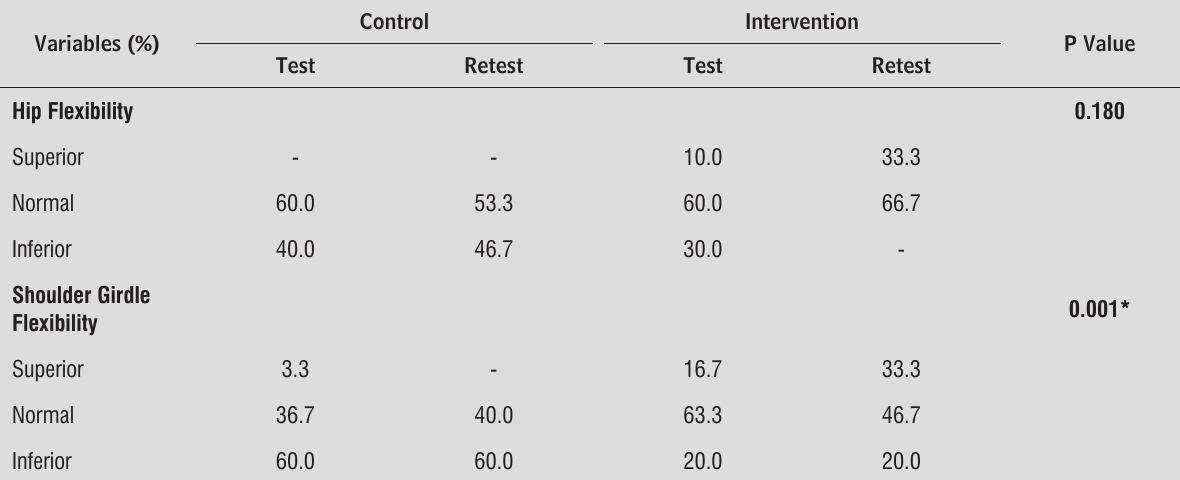
Table 1 - Flexibility levels of the elderly subjects in the